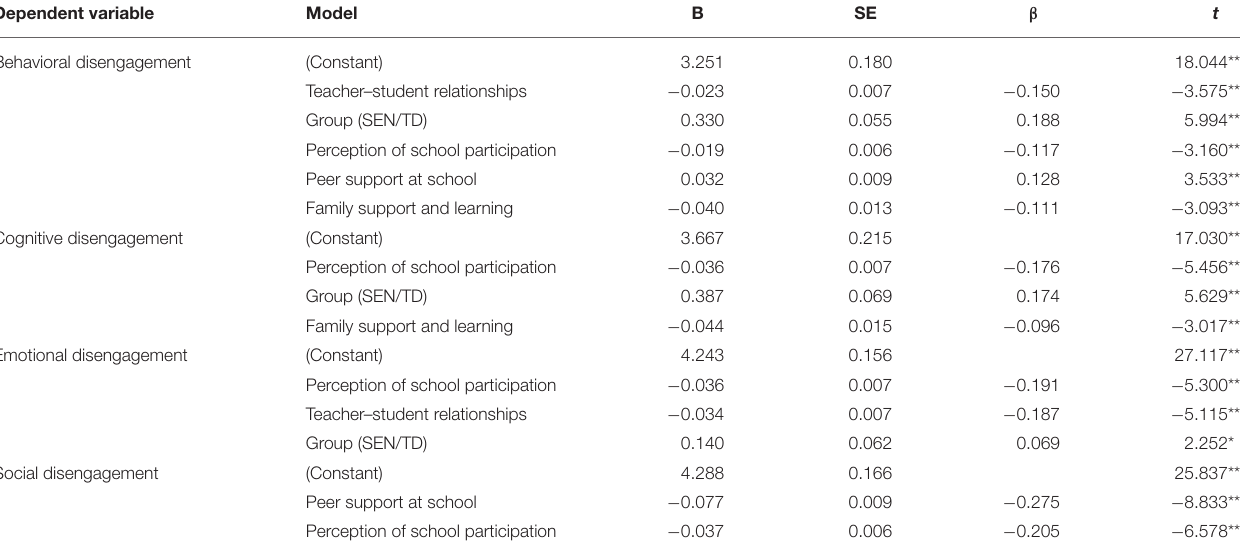
TABLE 3 | Linear regression models for behavioral, cognitive, emotional, and social disengagement